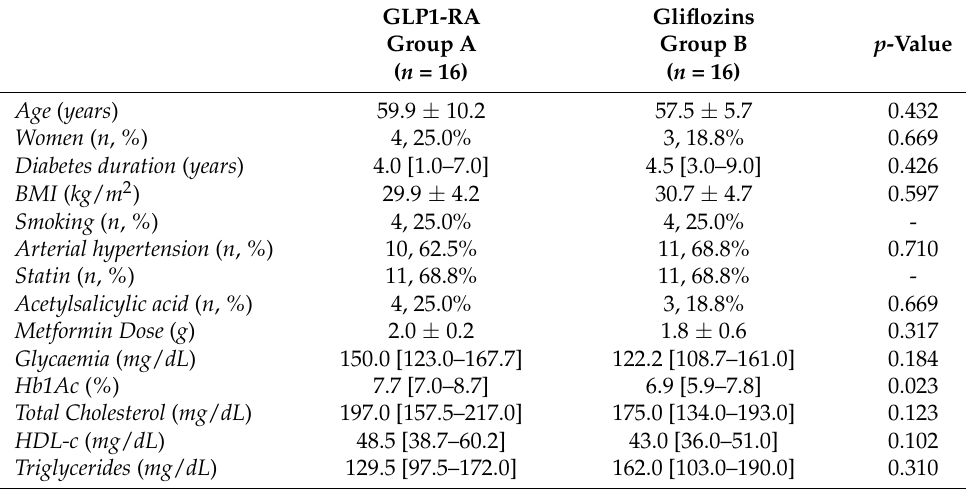
Table 1. Clinical characteristics of the population.